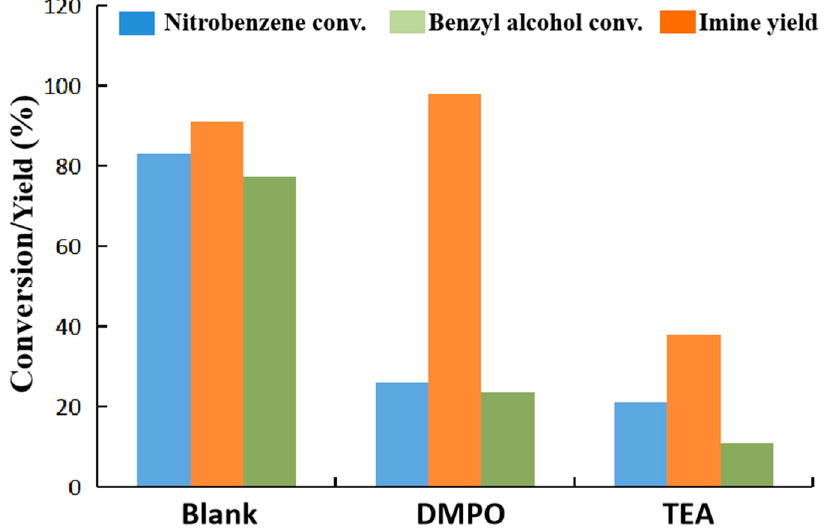
Figure 9. The conversions of nitrobenzene and benzyl alcohol, and the yield of imine by adding different